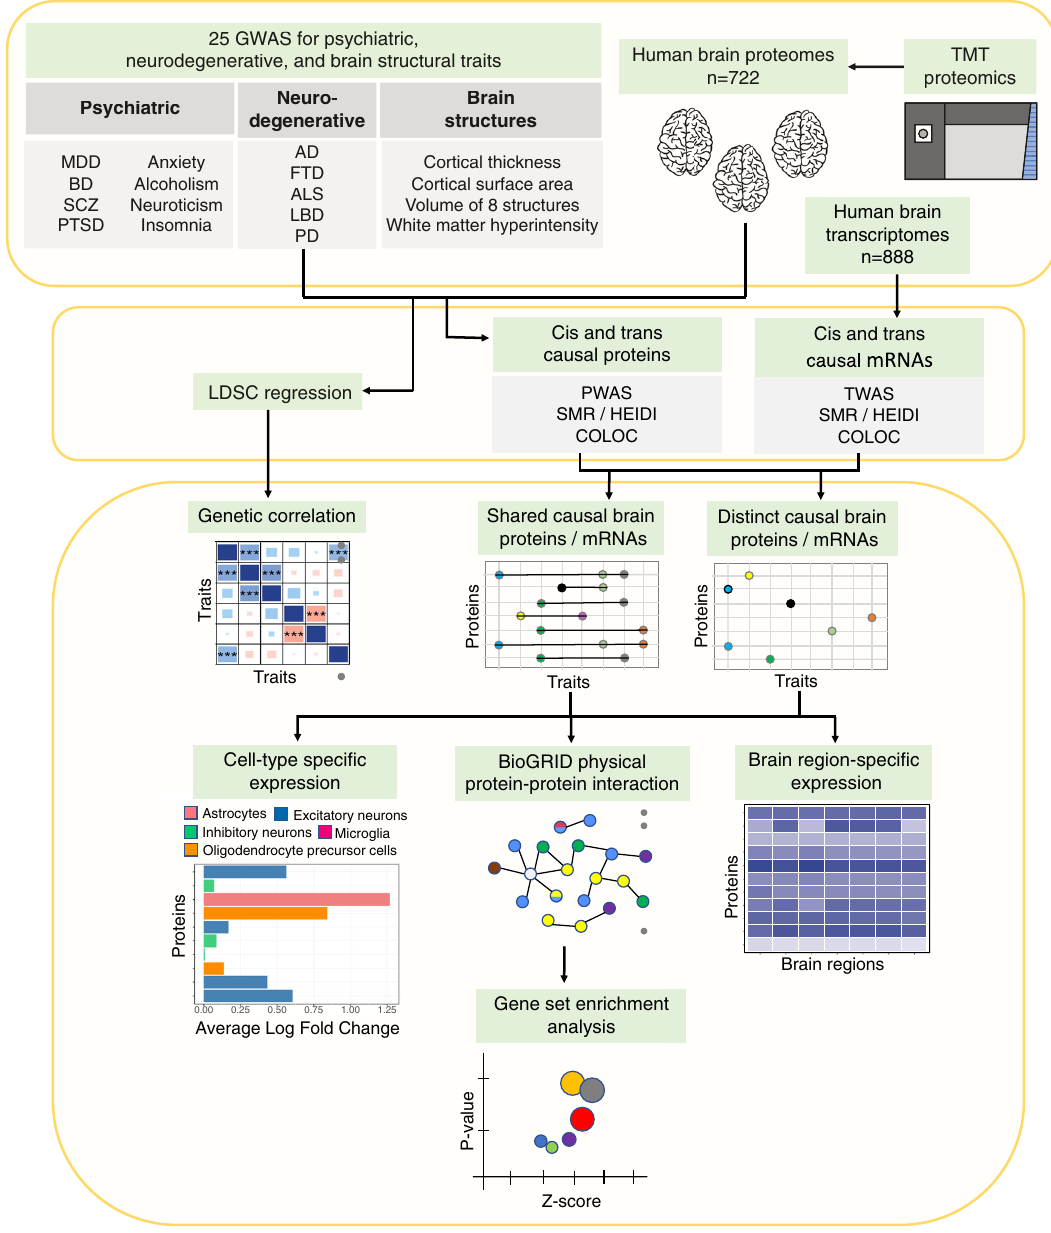
Fig. 1 | Study design. This is a summary of the analyses performed in this